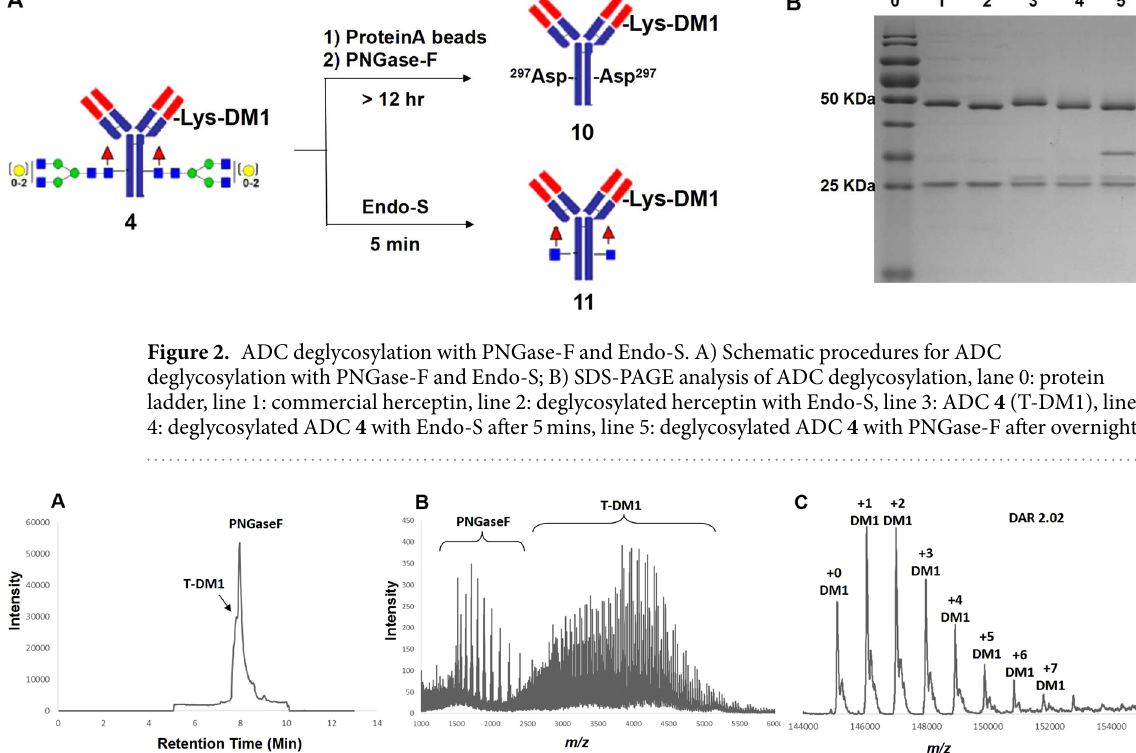
ADC (Fig. 3C and F) were simplified with only mixed m/z values of different payload numbers. The DAR was then easily calculated as the average payload number based on the sum of all deconvoluted mass intensities. The deglycosylation of IgG by PNGase-F usually requires long-time treatment (for overnight in the literature) that is not compatible to real-time monitoring. Recently, we have developed an efficient approach 8, 36 for IgG glyco-remodeling and the rapid deglycosylation activity of an Endo-N-acetylglucosaminidase from Streptococcus pyogenes (Endo-S) 37 inspired us to employ this enzyme for ADC deglycosylation and real-time DAR detection. Fig. 2 showed the comparison of PNGase-F and Endo-S for ADC deglycosylation. Endo-S cleaves the glycan between the GlcNAc β 1,4GlcNAc motif completely within 5 min at a very low enzyme concentration (1.5 μ g/mL). SDS-PAGE in Fig. 2B showed the efficient deglycosylation of both IgG (lane 2) and ADC (lane 4) by Endo-S as their heavy chains shifted downside ~2 KDa compared with the bands before deglycosylation (lane 1 and 3). On the other hand, PNGase-F digestion required a higher enzyme concentration (200 μ g/mL) and more than 12 hr incubation to complete the deglycosylation. The band around 35 KDa in Fig. 2B lane 5 is the PNGase-F, on the contrary, there is no detectable band of Endo-S around 100 KDa (molecular weight of Endo-S). More importantly, because of long-time digestion by PNGase-F, the drug conjugation of ADC may still be running on and DAR value could increase during the deglycosylation, therefore pre-purification of ADC by protein-A affinity chroma- tography is needed before the deglycosylation and DAR detection by PNGase-F approach. The rapid and robust deglycosylation of ADC by Endo-S encouraged us to further compare the DAR determi- nation via LC-MS with the data of PNGase-F treated ADC. In Fig. 3, panel A showed the total ion chromatogram